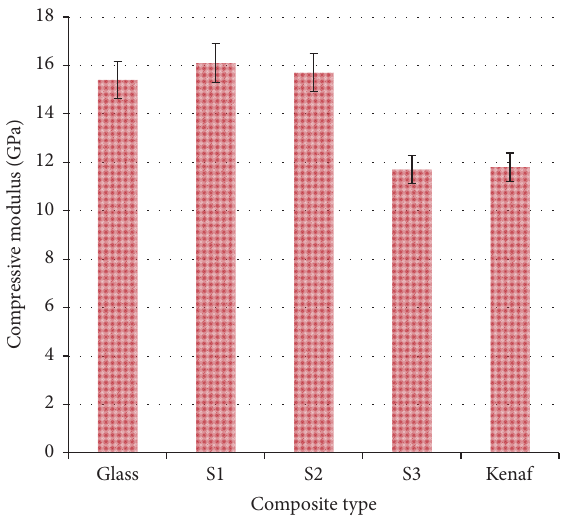
Figure 6: Compressive modulus of composites.